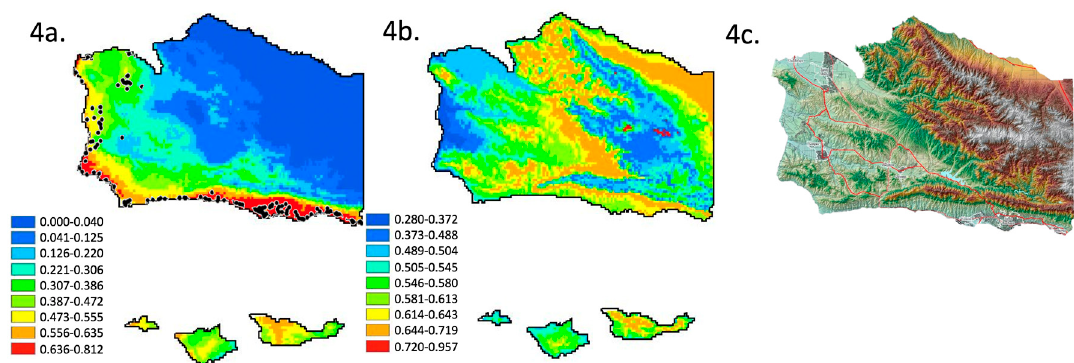
Figure 4. Results of a MaxEnt climate niche analysis for the current and future distribution of monarch butterfly overwintering habitat in Santa Barbara County, California: ( a ) model for the current distribution using an optimized regularization parameter, WorldClim 2.0 layers, and two elimination methods for reduction of over parameterization which converge on the selected layers, and showing the location of known overwintering sites (as in Figure 1) ( b ) model for the future distribution using an optimized regularization parameter, WorldClim 1.4 layers under the RCP6.0 projection, and two elimination methods for reduction of over parameterization which converge on the selected layers, and ( c ) relief map of the county. The difference between present and extrapolated maps generated by this model suggests the current coastal zone/coastal valleys distribution will be replaced by a more complex distribution where the probability of suitable climatic conditions relate to, but are not proportional to elevation. Instead, it is bimodal (low near the coast, higher in coastal ranges, low again on the slopes of interior ranges, and highest on mountain tops). A cluster of mountain top locations would be the highest probability sites in the entire county (middle of right half of ( b )).